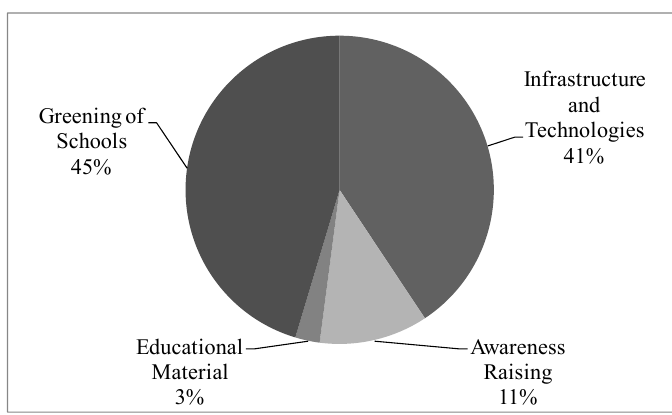
Figure 2. Businesses donations of UCO between 2014 and 2018.